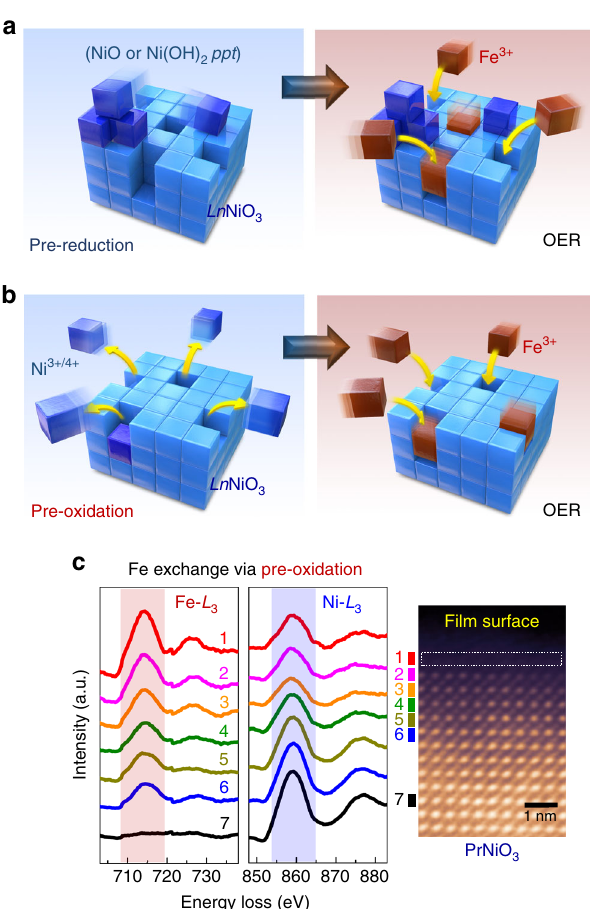
Fig. 2 Schematic illustrations and analytical evidence of surface Fe exchange. a Pre-reduction reactions are carried out in a 0.1 M KOH aqueous solution in a range of 0.62 – 1.3 V vs. reversible hydrogen electrode (RHE) so that Ni 3 + in the nickelate lattice is extracted out. The resulting formation of nanoscale NiO (or Ni(OH) 2 ) precipitates is identi fi ed. When the fi lm after pre-reduction is oxidized in a 0.1-mM-Fe-containing KOH aqueous solution for measurement of the current density, Fe 3 + ions in the solution appear to fi ll the Ni vacancies, resulting in the Fe exchange. b A similar procedure occurs during the Fe exchange following the pre- oxidation reaction. Ni dissolution is observed when nickelate thin fi lms are in highly oxidizing conditions (>1.75 V vs. RHE). Subsequently, the Ni vacancies created by the pre-oxidation reactions are fi lled again with Fe ions from the Fe-containing electrolyte during the oxygen evolution reaction (OER). c A layer-by-layer EELS analysis of a PrNiO 3 fi lm subject to the Fe exchange via pre-oxidation demonstrates the gradual decline in the Fe- L 3 peak intensity and simultaneous increase of the Ni- L 3 peak,